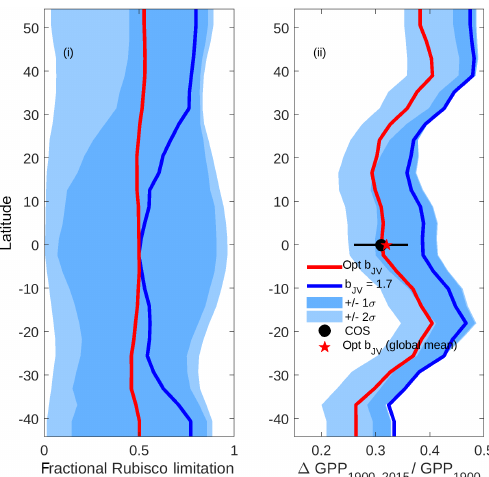
Figure 9. Latitudinal profiles of (i) fractional Rubisco-limited pho- tosynthesis (1980–2015) and (ii) the increase in gross primary production (GPP) relative to 1900 values. Simulations were per- formed under assumptions of dynamically optimised (red) and fixed b JV = 1 . 7 (blue). For computational efficiency, profiles are based on a sample of 1000 randomly distributed grid cells across the global ice-free land surface. The limits of the blue shaded areas repre- sent the results of simulations performed with fixed b JV = 1 . 7 ± 0 . 1 (dark shading) and b JV = 1 . 7 ± 0 . 2 (light shading), with lower lim- its corresponding to lower fractional Rubisco limitation and lower increase in GPP. In (ii) , the COS value represents the trend in global GPP inferred from the carbonyl sulfide tracer (Campbell et al., 2017).